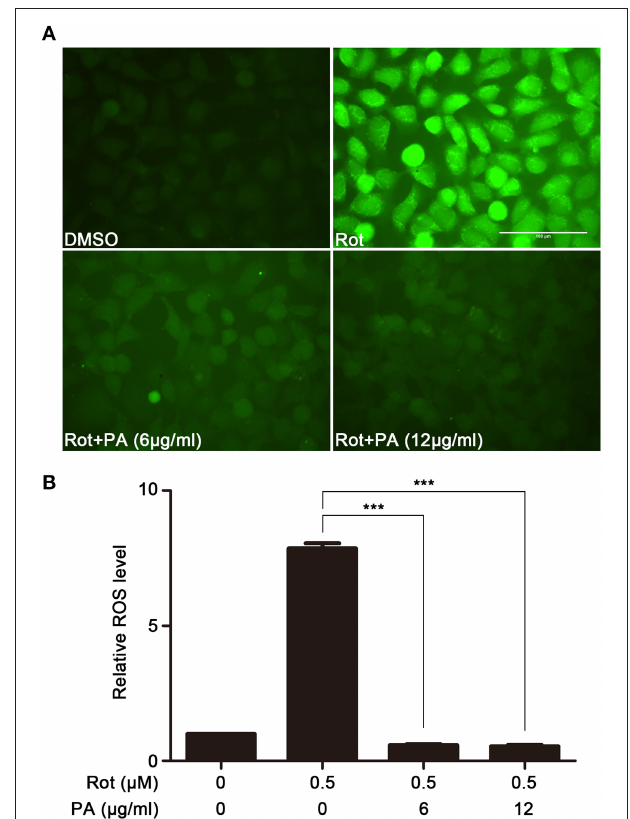
FIGURE 2 | Effects of PA on rotenone-induced ROS generation. (A) Representative images showing the preventive effect of PA against rotenone-induced ROS production. Scale bar: 100 µ m. (B) The fluorescence readings were determined with microplate reader. Data are from experiments performed in triplicate and repeated 3 times. *** P < 0.001, compared to